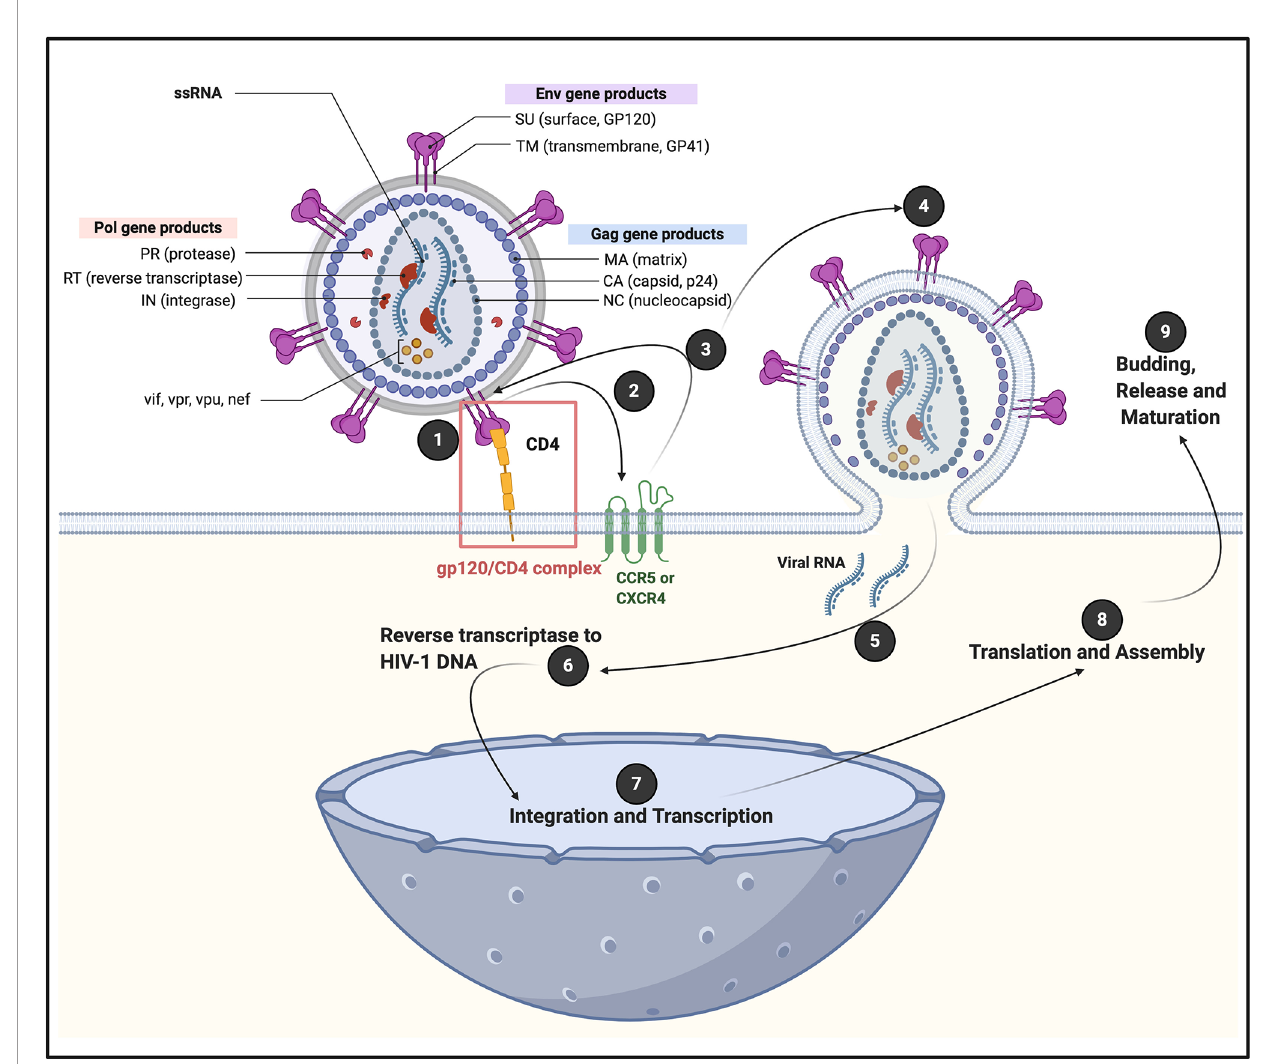
FIGURE 1 | A generic illustration of the initial attachment of HIV-1 to a CD4 + cell, resulting in in a series of sequential steps that allows viral replication. Initial HIV-1 cell contact result in the interaction of viral envelope glycoprotein gp120 with CD4 receptors, to form a (1) gp120/CD4 complex on the host cell surface (4). This interaction induces a conformational change in the envelope protein that exposes a chemokine receptor binding site. (2 and 3) Association of gp120 with chemokine receptor CC chemokine receptor 5 (CCR5) or chemokine receptor 4 (CXCR4), promotes a rearrangement of the transmembrane envelope protein gp41, resulting in the (4) fusion of the viral and cellular membranes and the entry of the viral capsid into the cell (4 – 6). CXCR4 and CCR5 were initially identi fi ed for their role in HIV-1 entry of CD4 + T cells through its interaction with gp120 (7). CCR5 is a G protein-coupled receptor (8), with seven transmembrane segments and an eighth a -helix parallel to the plasma membrane (6). (5) Viral RNA is now released into the cell, followed by (6) reverse transcriptase to HIV-1 DNA; (7) integration and transcription in the nucleus; (8) translation and assembly in the cell cytoplasm; followed by (9) budding and release and maturation. Diagram created with BioRender (https://